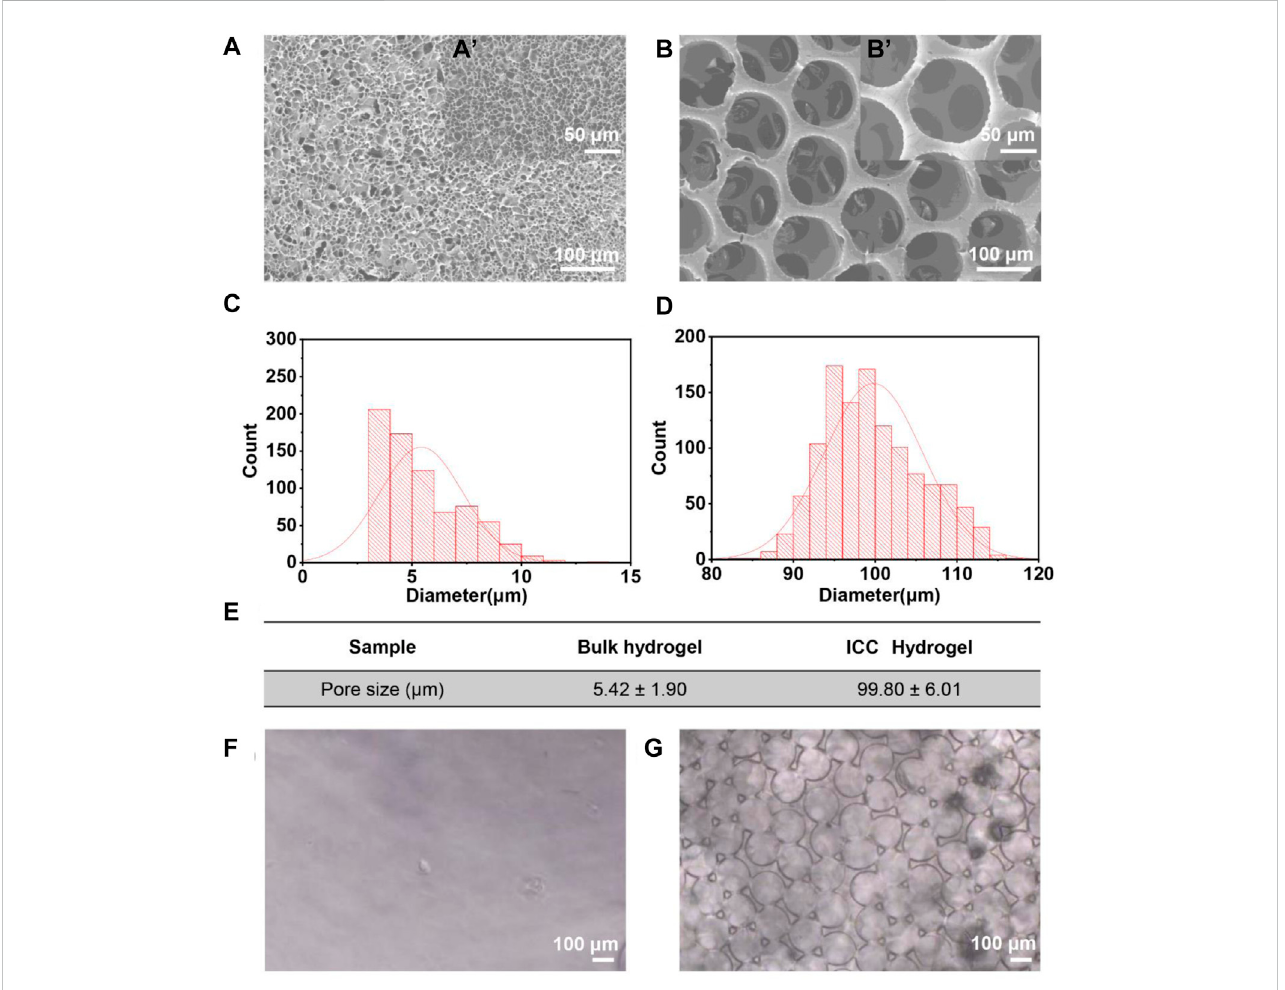
FIGURE 2 (A) SEM image of GelMA bulk hydrogels. (a`) Magni fi cation images of GelMA bulk hydrogels. (B) SEM image of GelMA ICC hydrogels. (b`) High magni fi cation image of GelMA ICC hydrogels. (C,D) Histogram of pore size (diameter) distribution of GelMA bulk and GelMA ICC hydrogels, respectively. (E) Analysis of pore size from the SEM images by ImageJ. (F) Microscope image of GelMA bulk hydrogels. (G) Microscope image of GelMA ICC